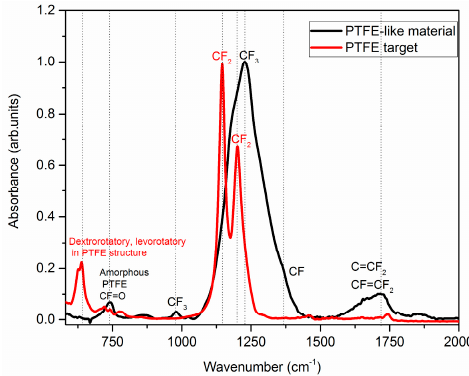
Figure 2. Fourier Transform Infrared (FTIR) spectra of the PTFE target ( red curve ) and PTFE-like material obtained by radiofrequency (RF) magnetron sputtering ( black curve ).